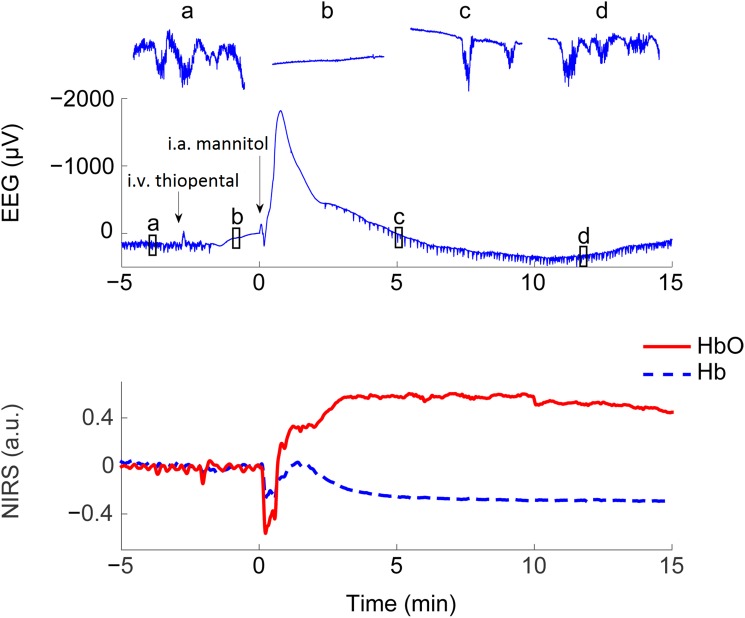
Characteristic EEG and NIRS responses seen during the BBBD procedure.Specimen traces illustrating simultaneous changes in raw EEG (upper graph) and NIRS signals (lower graph) during right carotid intra-arterial (i.a.) mannitol infusion. Deepening anesthesia with intravenous (i.v.) thiopental bolus (marked with an arrow) induces a baseline shift and suppresses activity at conventional EEG frequencies (insets a to d show 15 s sample traces on a 6 times expanded vertical scale) prior to mannitol infusion. Mannitol infusion (2nd arrow) then induces a multi-phasic potential response that begins with a pronounced negative shift reaching nearly -2000 μV in less than 1 min. The negative peak is followed by a slow potential descent below the pre-bolus level. Note the emerging burst-suppression (c) and subsequent faster EEG activity (d) similar to baseline state (a) as the thiopental effect slowly dissipates over 15 minutes. The simultaneously recorded NIRS graph shows first how the i.v. thiopental bolus produces a minor elevation to both NIRS HbO and Hb signals (red solid line and blue dashed line, respectively). When the 30 s i.a. mannitol infusion starts both NIRS signals plummet due to dilution of blood and they start to increase towards the original levels after the infusion. Subsequently, HbO rises above the baseline and stays there over the 15 minutes. On the other hand, Hb approaches the baseline level but soon starts to fall again obtaining a steady level clearly below the original baseline.